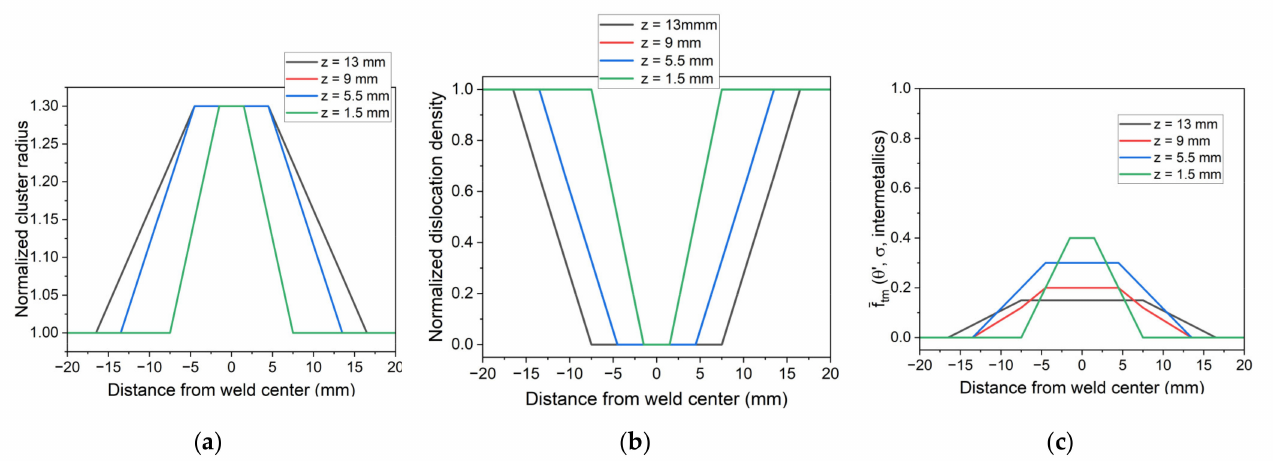
Figure 16. The initial states imposed according to electrical resistivity measurements at different locations in the weld for the ( a ) normalized radius of clusters (curves at z = 5.5 and 9 mm are superimposed); ( b ) normalized dislocation density (curves at z = 5.5 and 9 mm are superimposed); and ( c ) maximum normalized volume fraction of non-hardening phases.